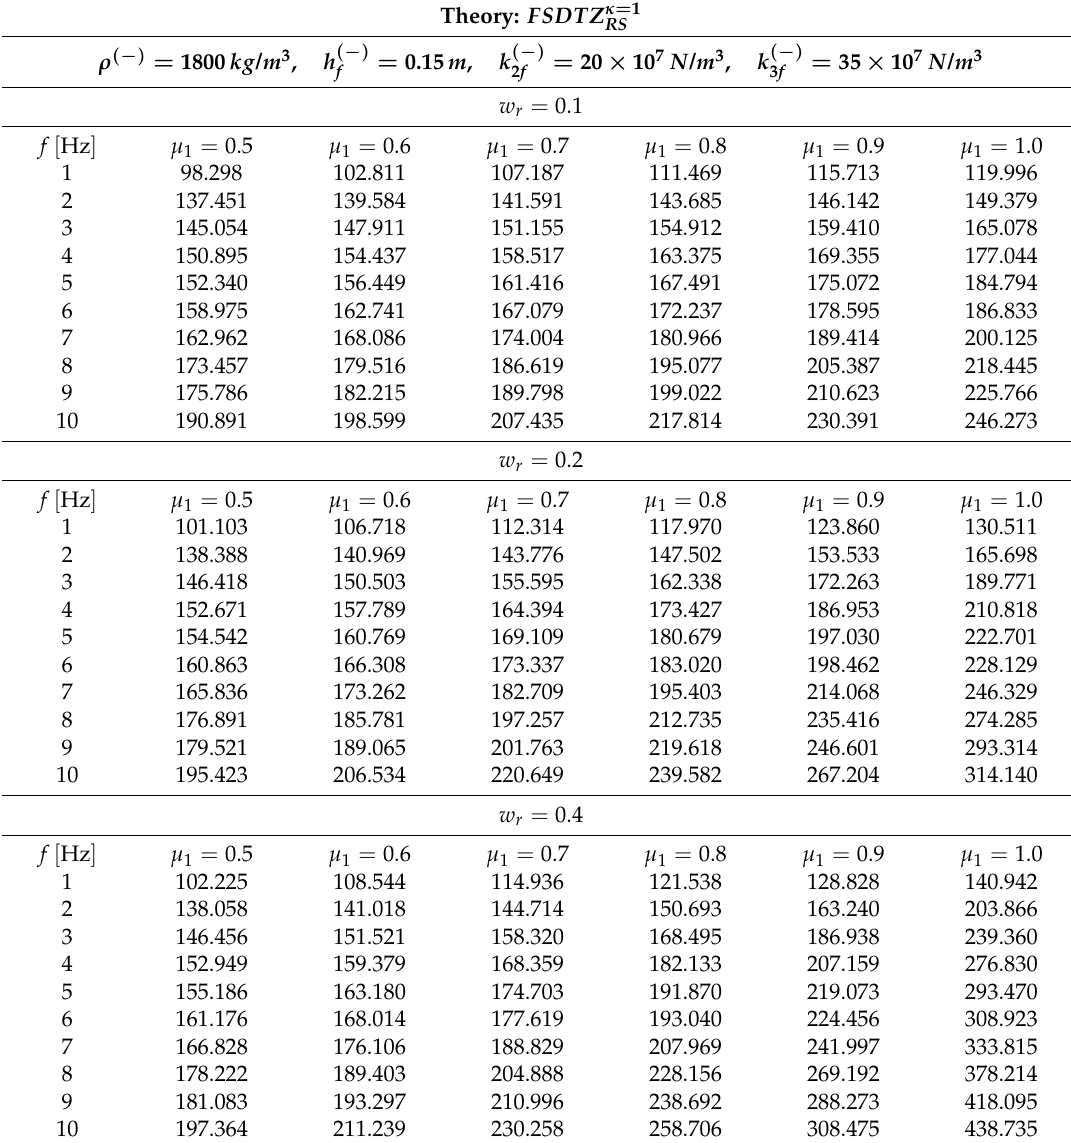
Table 9. First ten natural frequency variations for FSDTZ κ = 1 (Figure 4c) reinforced by CNTs distributed as in Figure 5c for different mass fractions w r when varying the parameter of agglomeration µ 1 with µ 2 = 1. The Chebyshev-Gauss-Lobatto grid distribution was employed, with I N = 31, I M =